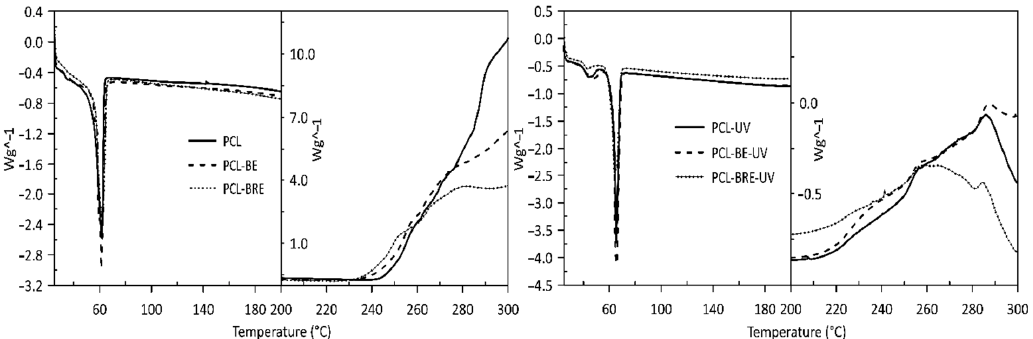
Figure 4. DSC degradation test for the PCL samples under an oxygen atmosphere. The curves for the TGA, PLA, and PCL composites indicate the influence of not only bentonite, but also the AO on the stability of both materials after solar ageing. The PLA curves in Figure 5 show that the initial release of moisture and other volatiles occurred first (a weight loss in the region below the thermal degradation). The onset of PLA-UV degradation was already apparent at 354 °C, appearing for PLA-BE-UV at 343 °C and PLA-BRE-UV at 347 °C. The main degradation peaks were visible at 340 °C for PLA-UV, at 331 °C for PLA-BE-UV, and at 335 °C for PLA-BRE-UV. Degradation was at a slower rate for PLA-BRE-UV manifested by an initially slower loss in mass (Table 3). The TGA curves in Figure 6 describe the degradation process of the PCL materials. The effect of bentonite was obvious, reducing the rate of degradation for PCL-BE-UV to 367 °C and PCL-BRE-UV to 360 °C, whereas PCL-UV was evident at 335 °C [54,55].